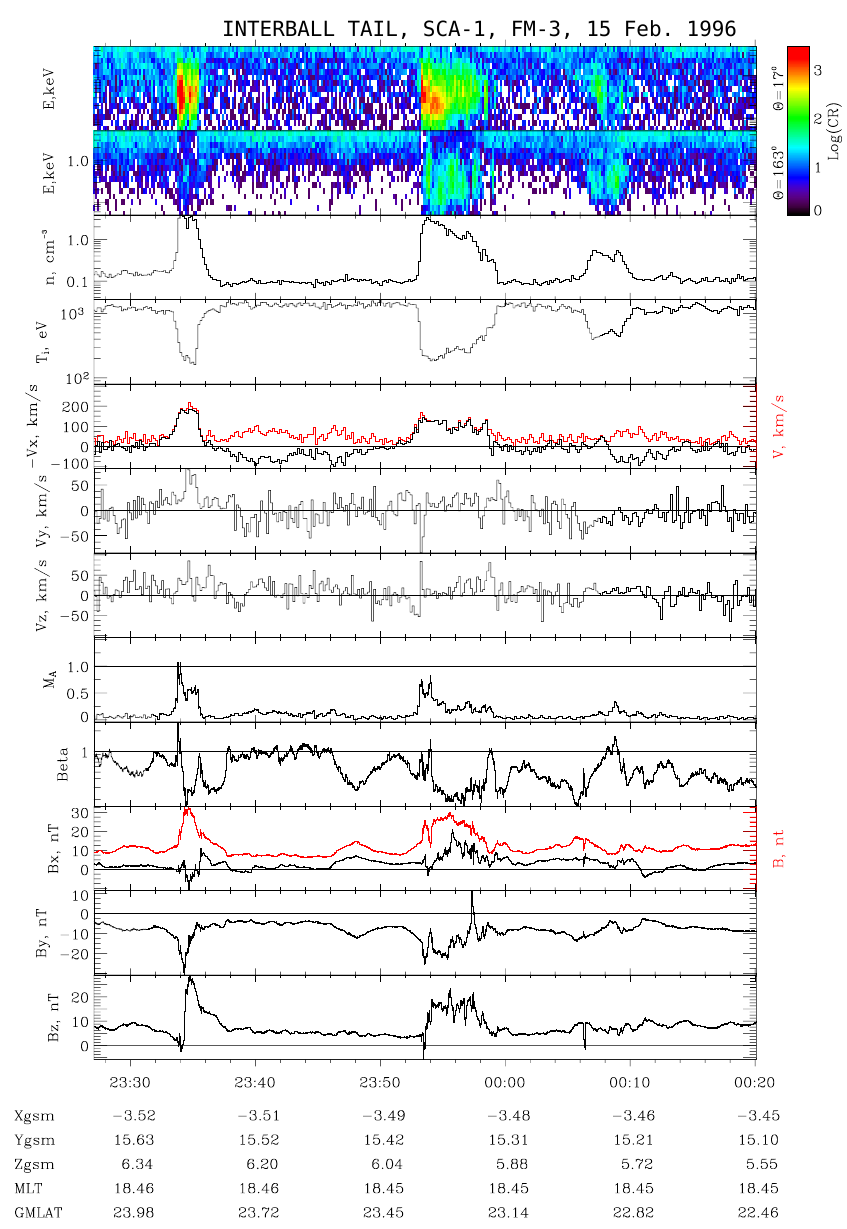
Fig. 4. Three LLBL transients are plotted as observed by Interball on 15 February 1996. See Fig. 2 caption for explanation. Note that within this succession of transients there is an inverse relationship between number density and velocity, on one side, and ion temperature, on the other